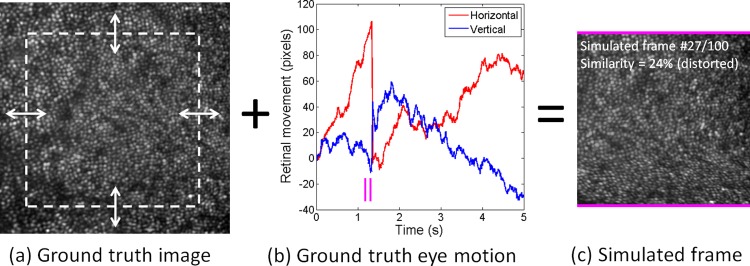
Ground truth data and generation of distorted SLO imagery.a) Cone photoreceptor mosaic 1.25° temporal to the fovea, generated from the average of 1000 frames acquired at 750 nm using flood-based adaptive optics. White box indicates the extent of the 400x400 pixel (192x192 μm) simulated SLO frame. b) Eye movement data in pixels (1 pixel = 0.48 μm) from the same sequence that was used to generate a. Eye motion was determined from cross-correlation of each of 1000 frames, measured at 200 fps, with the first frame in the sequence. c) One of the SLO frames simulated at 20 fps, generated by combining ground truth image and eye movement data (corresponding to time point indicated by magenta lines). Distortion is evident towards the bottom of the frame, which corresponds to a spike in eye movement. S1 Video shows all simulated frames for this sequence, after full-field registration of each frame to the first frame.